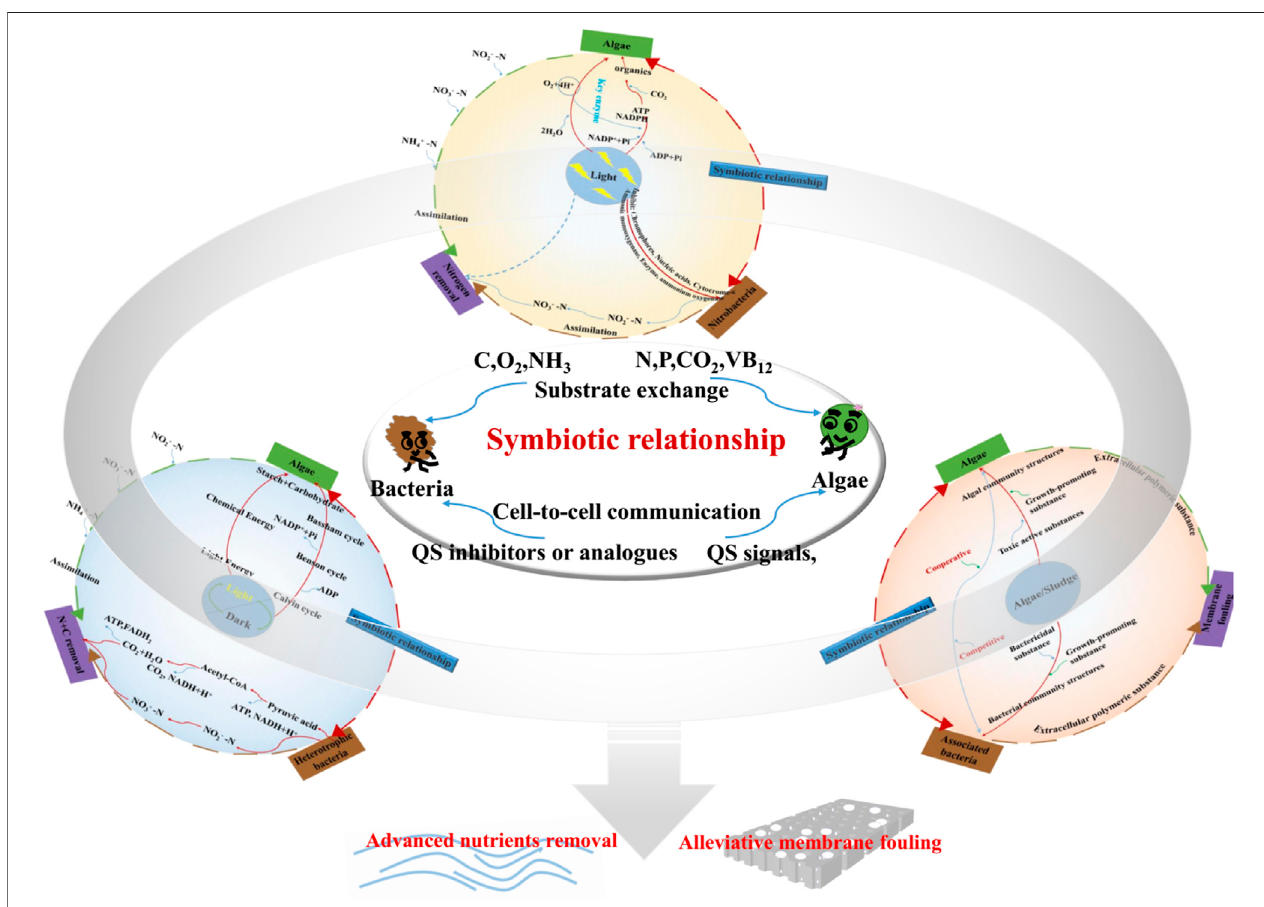
FIGURE 3 | Schematic diagram of the factors on the